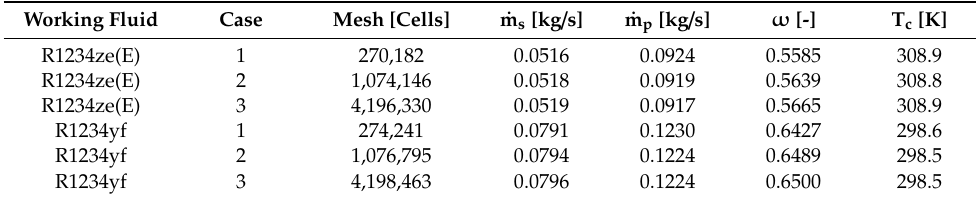
Table 1. Mesh sensitivity